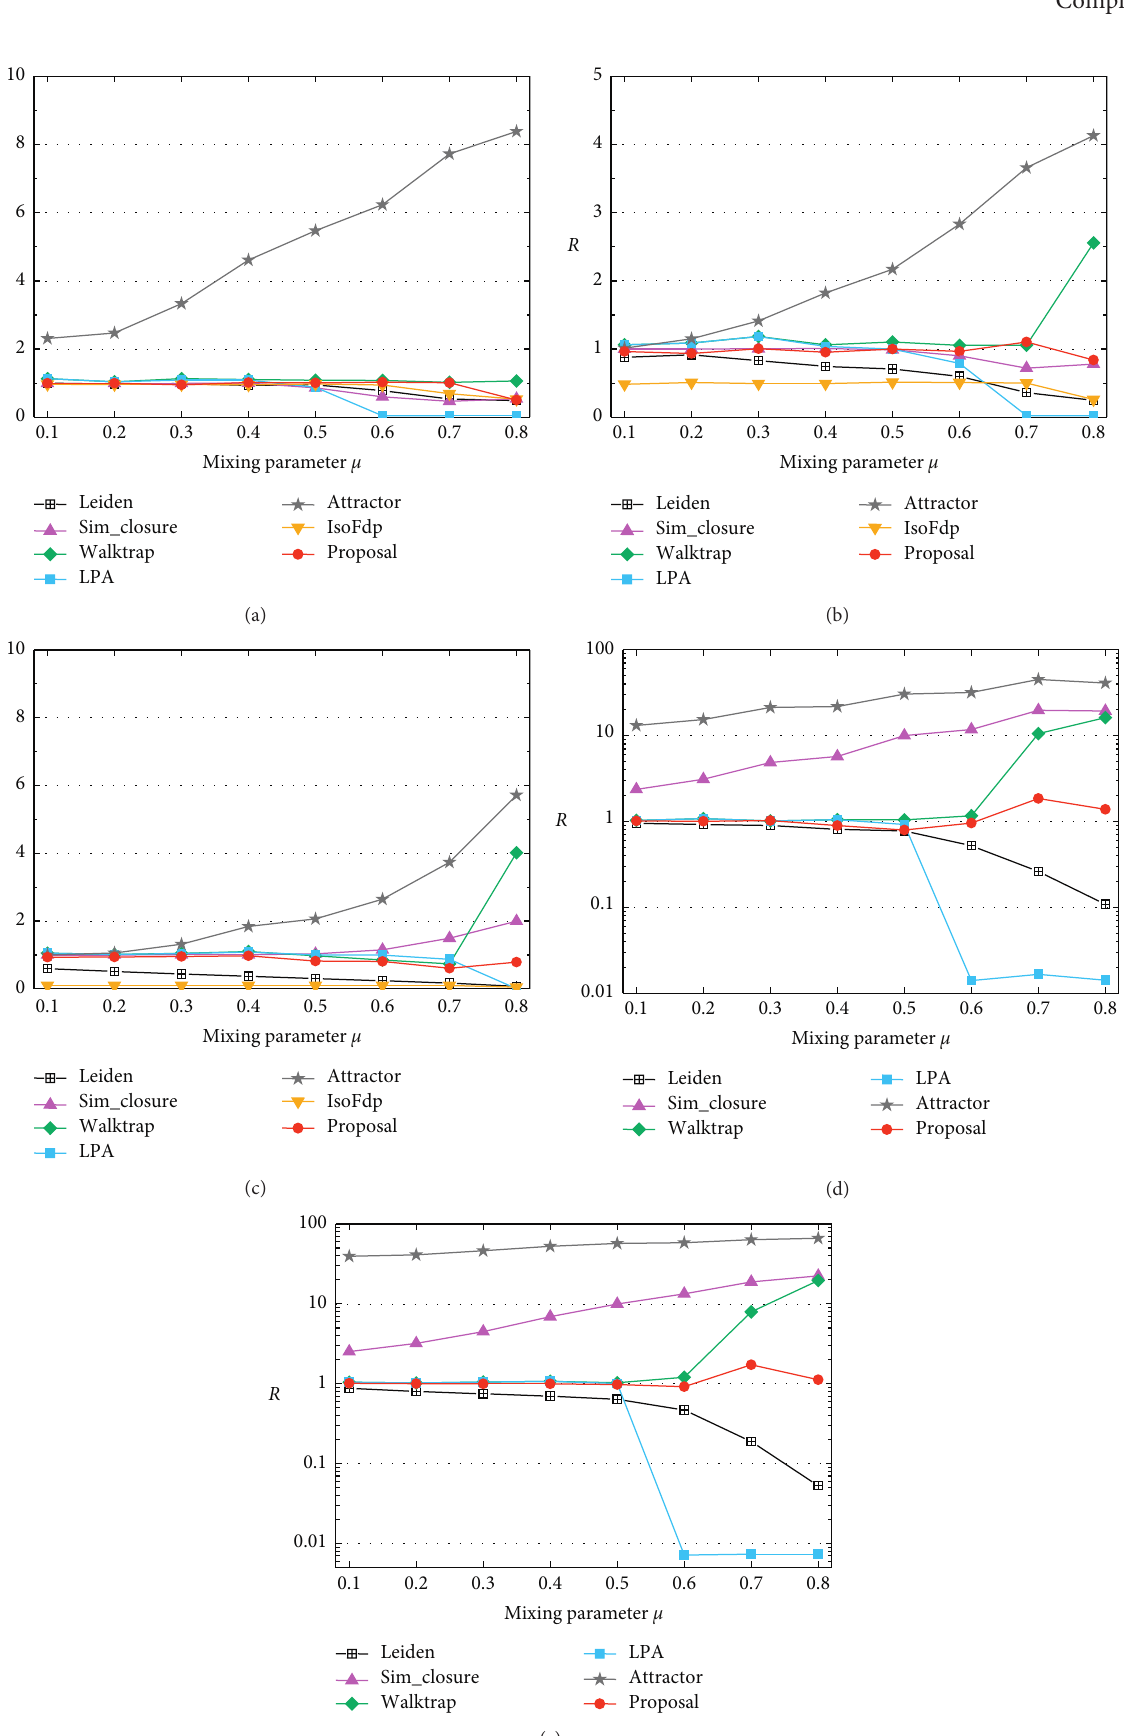
Figure 4: The ratio of the number of the detected communities to the real number of communities in the artificial networks. (a) LFR500. (b) LFR1000. (c) LFR5000. (d) LFR10000. (e)